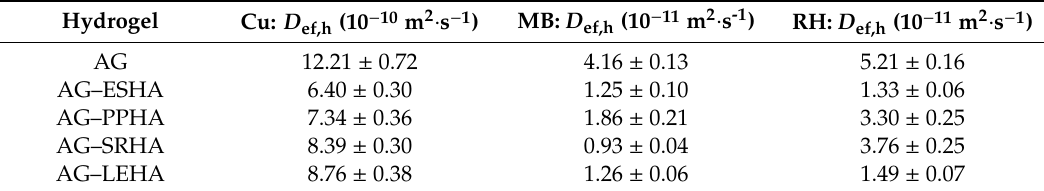
Table 2. The values of e ff ective di ff usion coe ffi cients of di ff usion probes in the AG and AG–HA